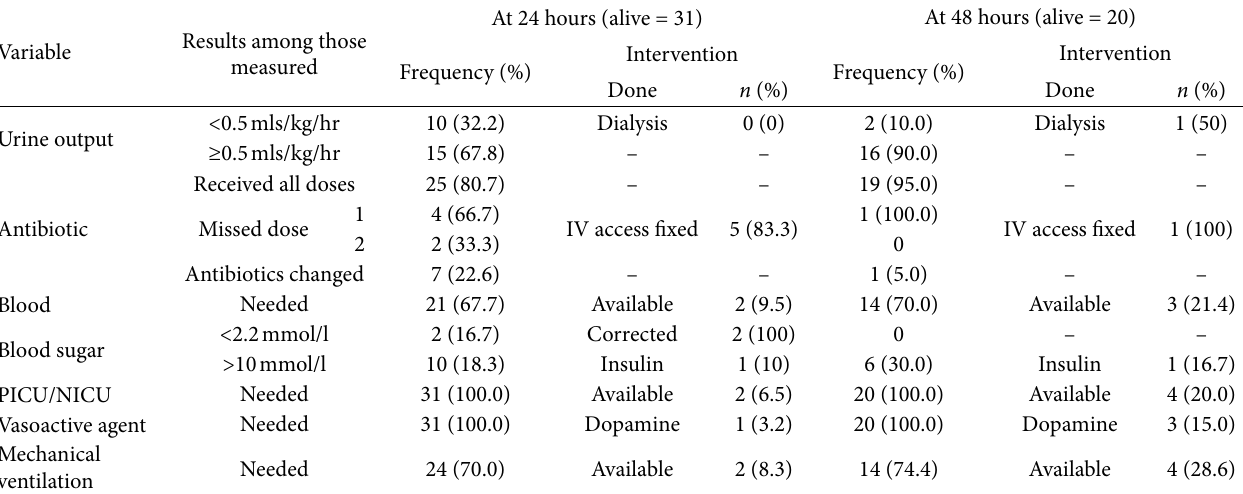
Figure 3: Audit of interventions measured at 24 and 48 hours of recognition of septic shock. Table 3: Audit of the results and interventions at 24 and 48